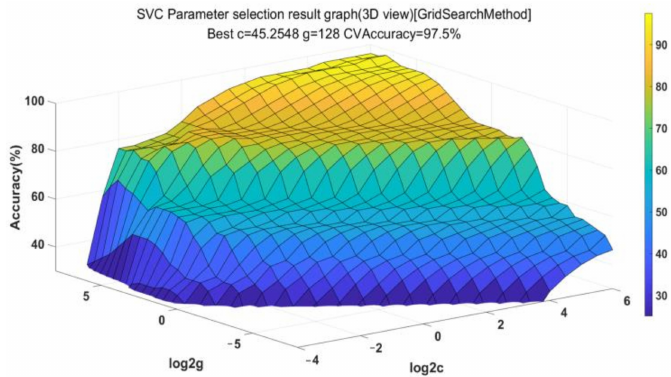
Figure 28. Accuracy of parameter classification.